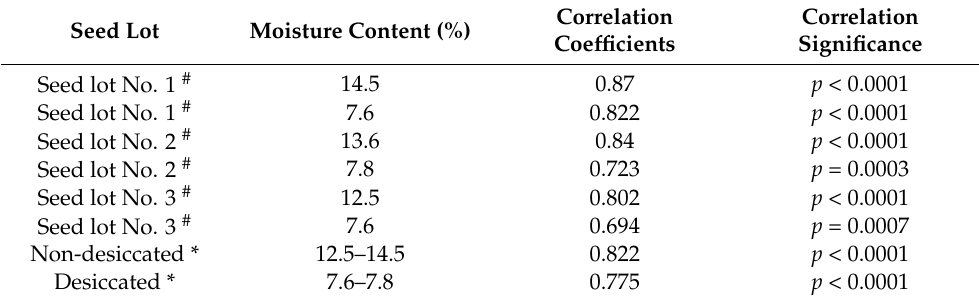
Correlation Coefficients